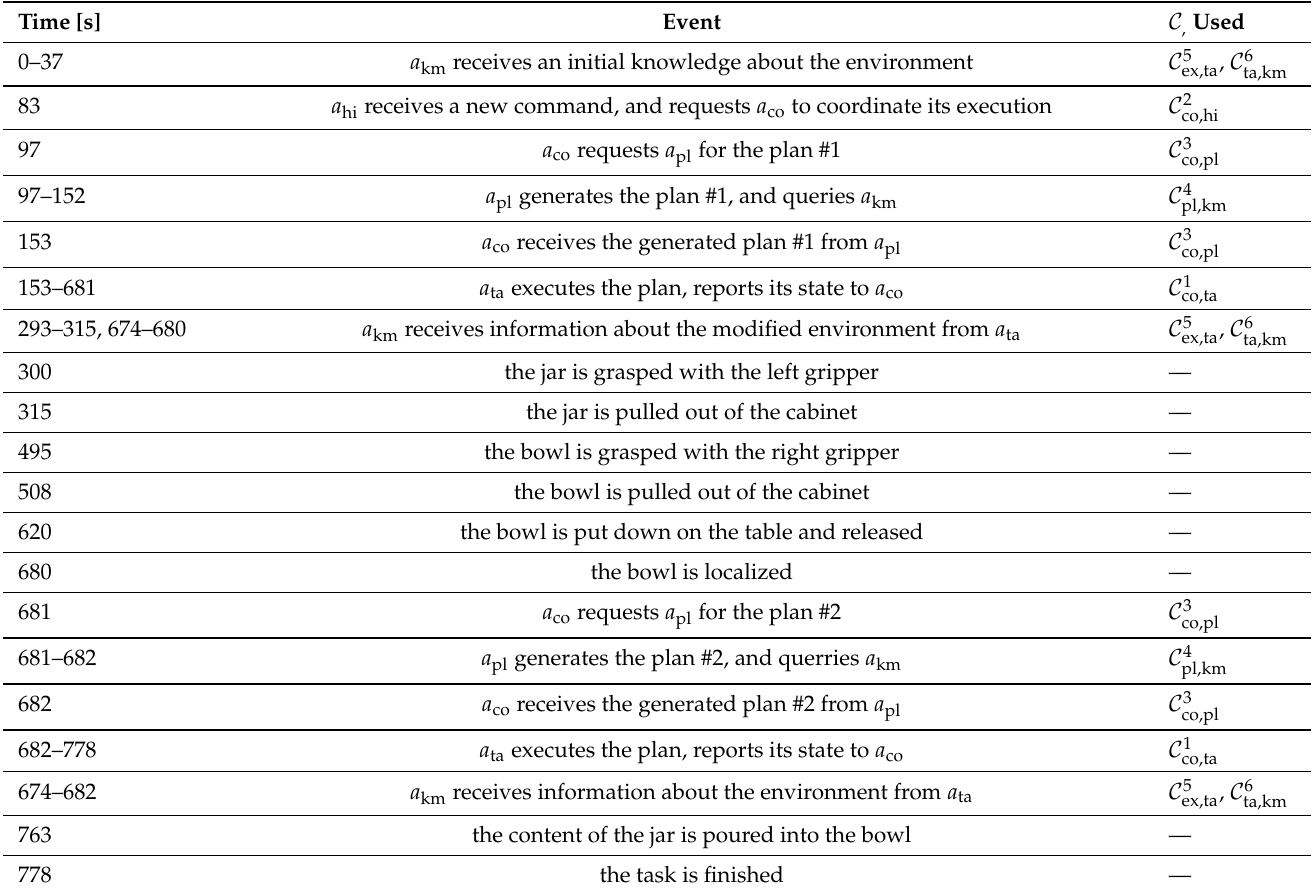
Table 7. Communicates and robot actions in the